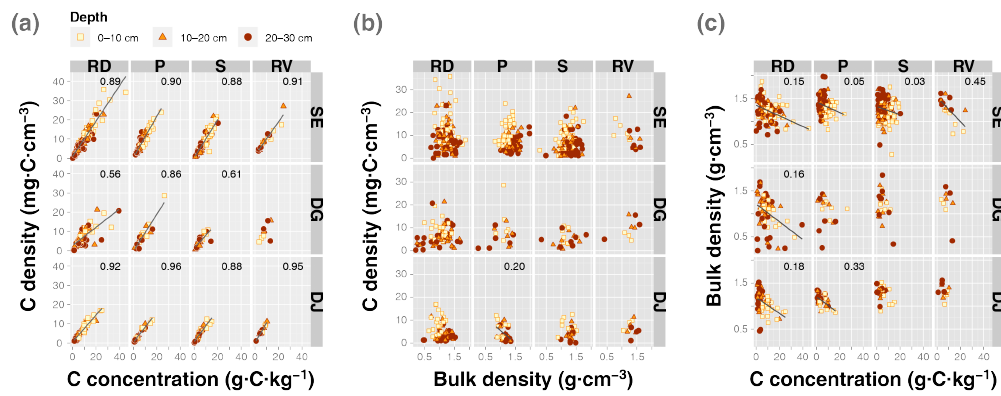
Figure 1. Pairwise relationships among soil bulk density, C concentration, and volume-based C density of soils in different urban green space types for three cities in South Korea ( a ): soil C concentration-C density, ( b ): soil bulk density-C density, ( c ): soil C concentration-bulk density). Where the linear regression was significant ( p < 0.05), a solid line and an R 2 value number are drawn (numbers in the upper right corner of each sub-panel). Abbreviations are explained in Table 1. Table 3. A three-way factorial ANOVA that tested for significant differences in soil bulk density, C concentration, and C density by city, UGS type, and soil depth. The table gives the p -values; those highlighted in bold are statistically significant ( p <